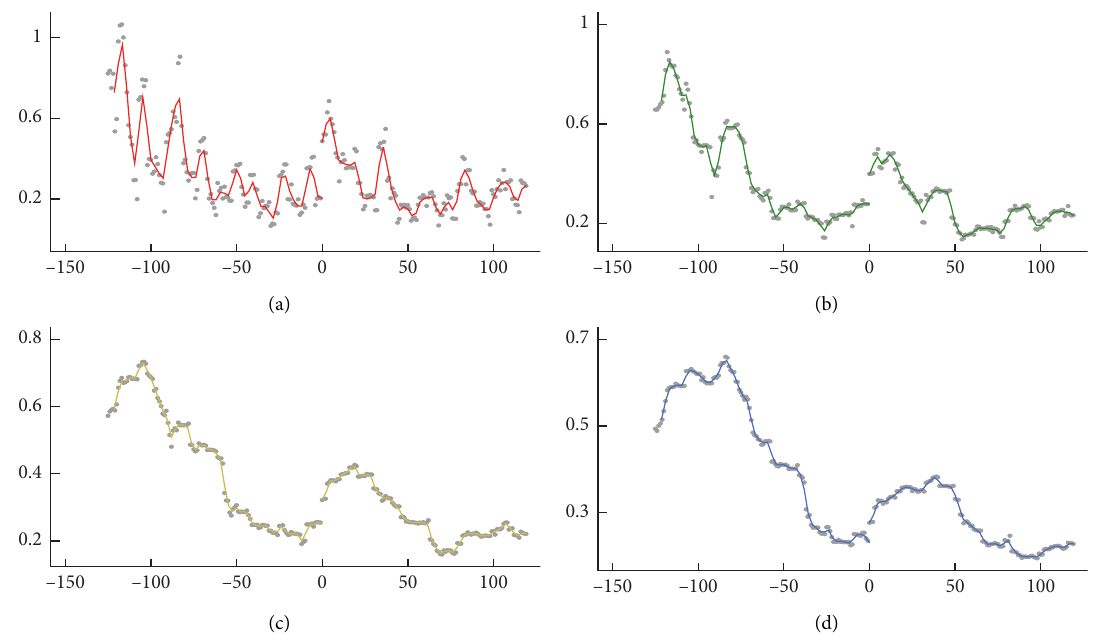
Figure 7: The RDD results of the consumption industry. (a) hv5, (b) hv15, (c) hv30, and (d) hv50.